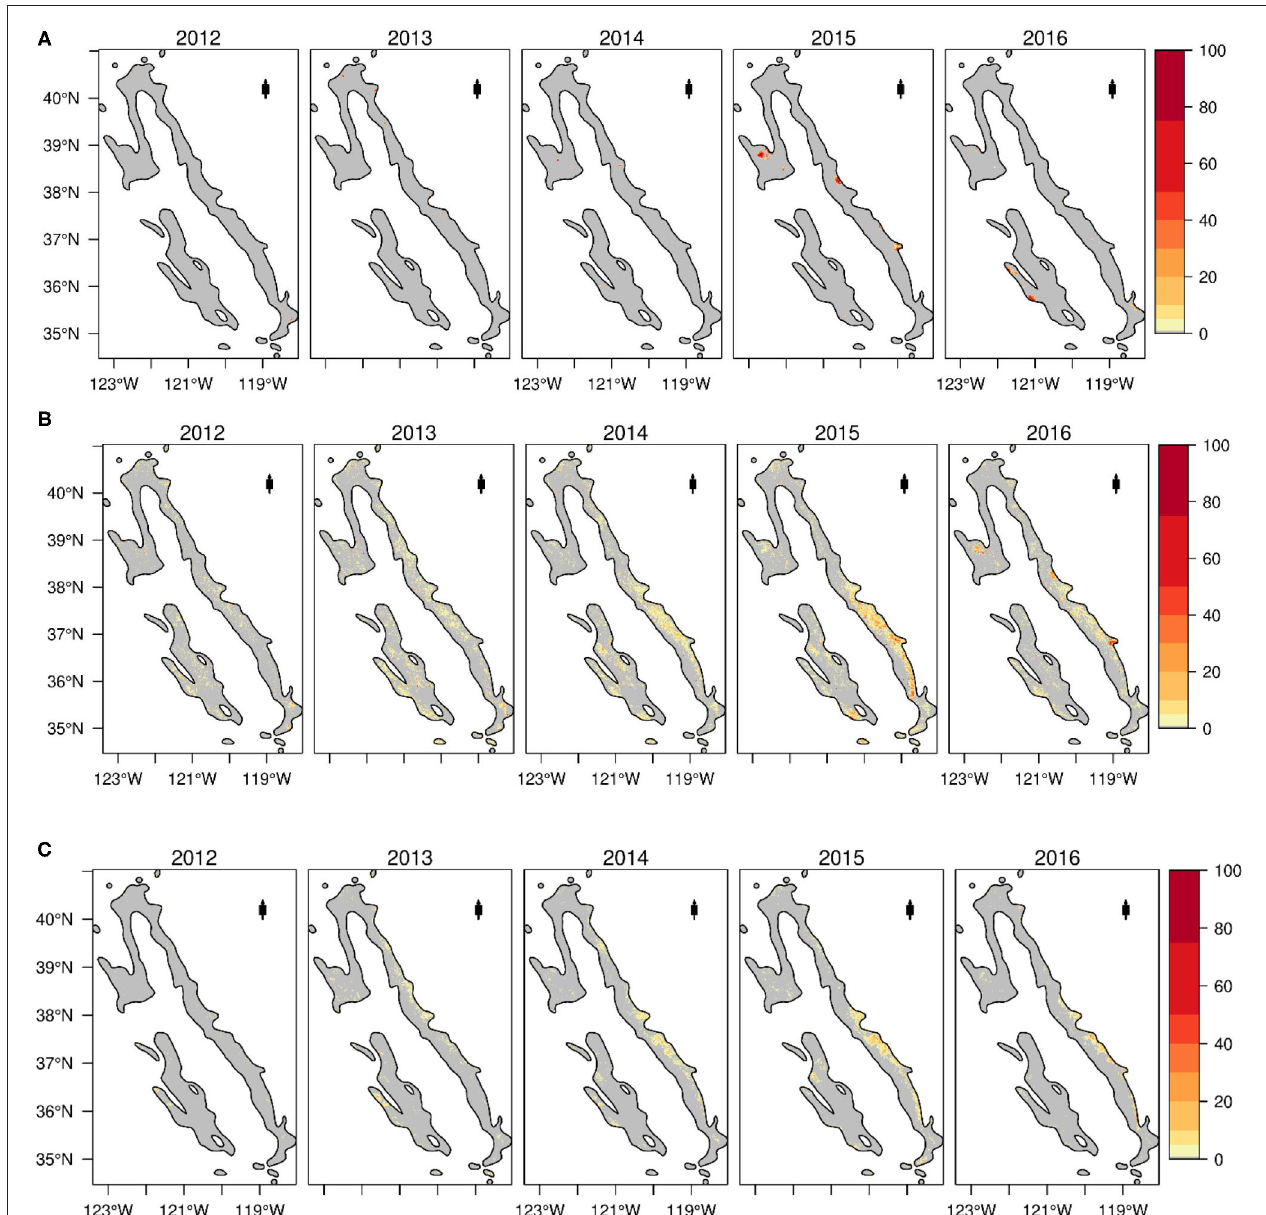
FIGURE 8 | Time series maps showing the spatial pattern of (A) Percent fire-induced tree cover loss; (B) Percent non-fire related tree cover loss; and (C) Percent non-fire related tree cover conditional change across blue oak woodlands during the 2012–2016